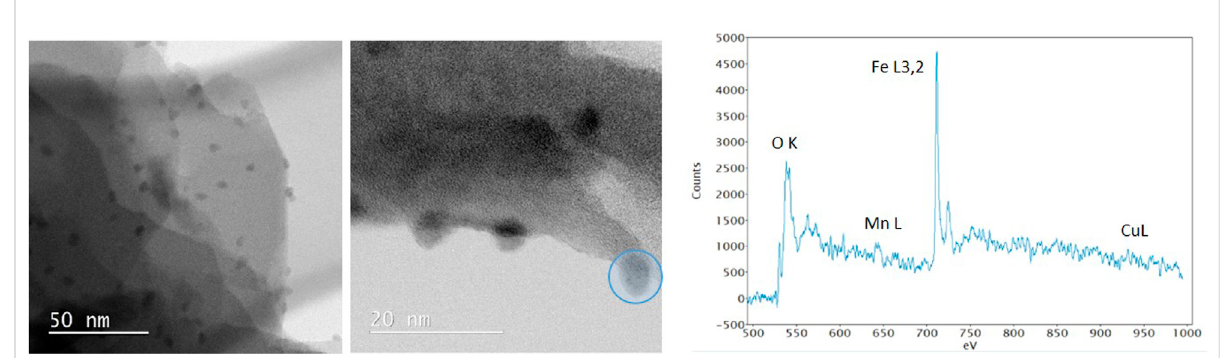
FIGURE 5 BF-STEM images with EELS spectrum of nanoparticle marked in blue circle of calc-CuFeMn – NaZ-50.